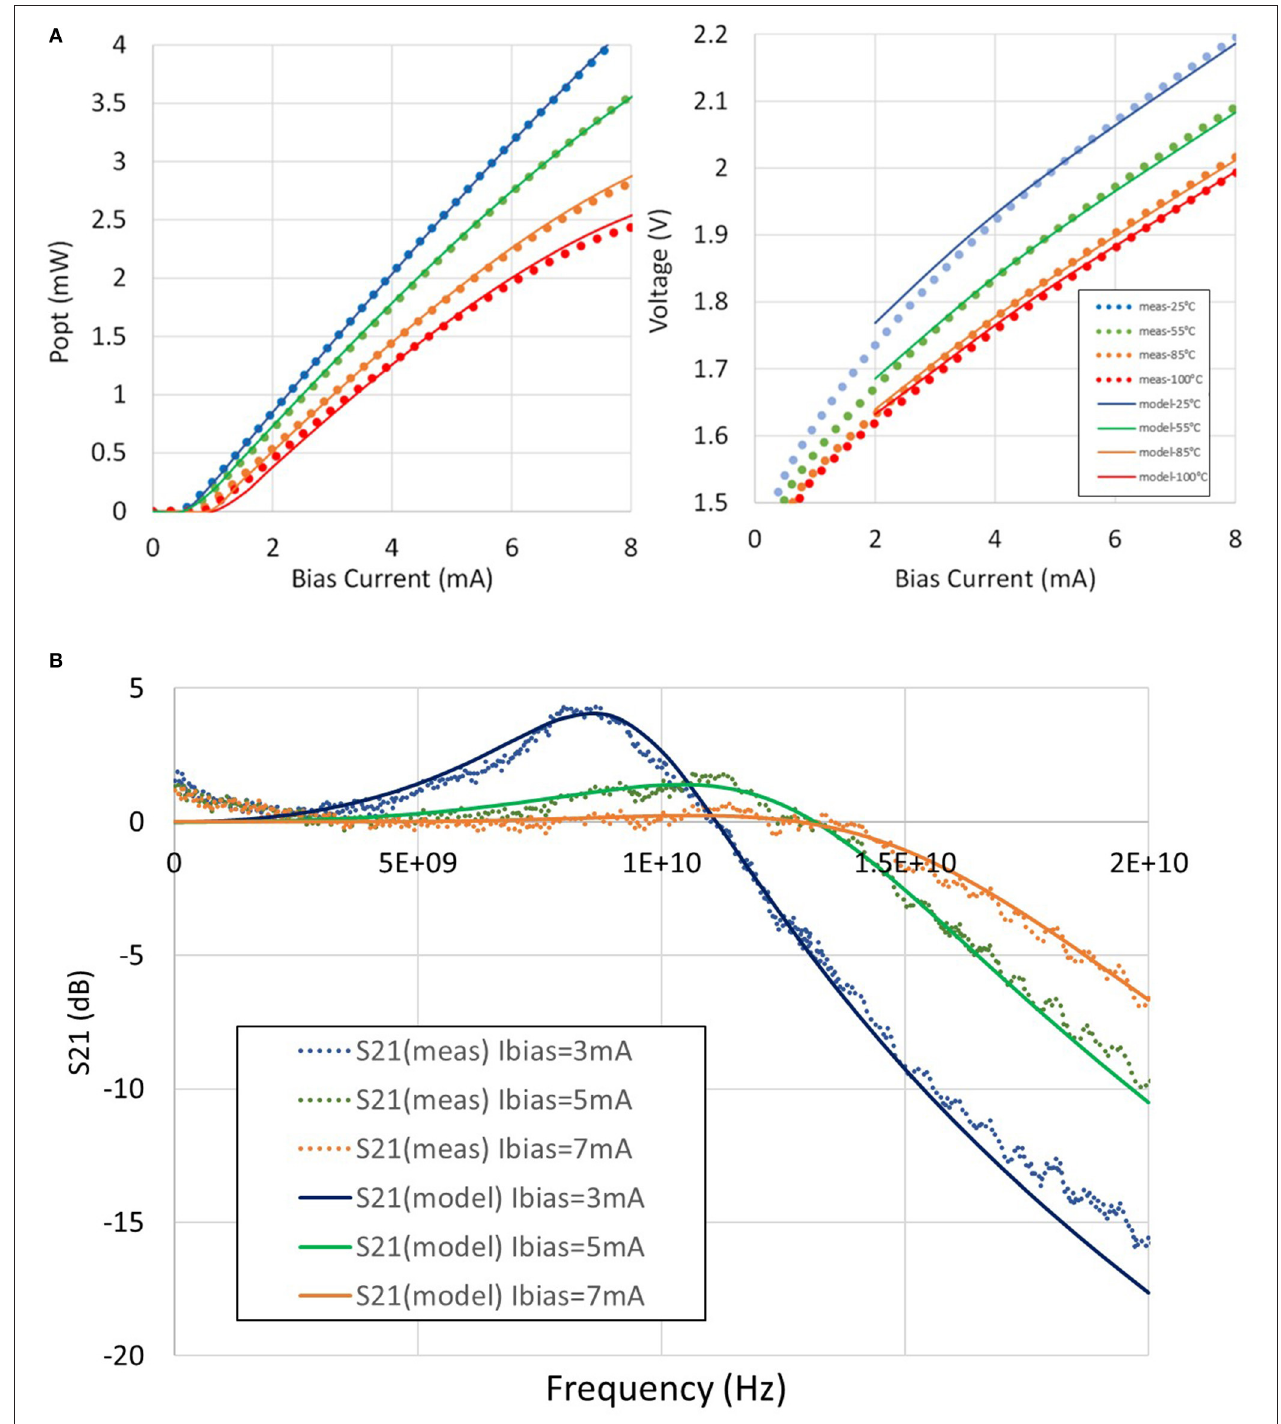
FIGURE 8 | Comparison between measured (dotted lines) and modeled (solid lines) VCSEL parameters. (A) DC measurement vs. modeled results for different temperature settings. (B) Normalized S21 measurement vs. modeled results for different bias settings.